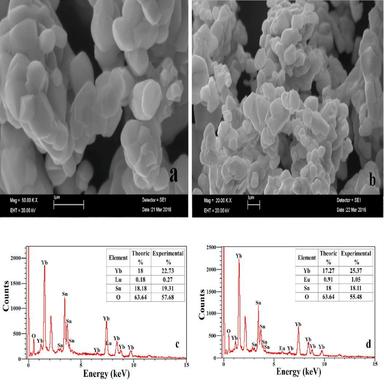
SEM image of (a) Yb1.98Lu0.02Sn2O7 (b) Yb1.90Eu0.10Sn2O7. The EDX spectra of (c) Yb1.98Lu0.02Sn2O7 (d) Yb1.90Eu0.10Sn2O7.